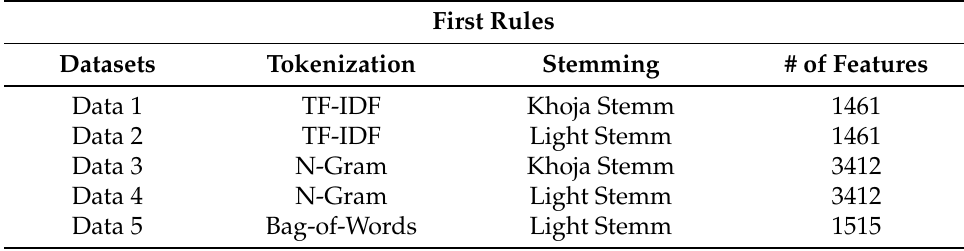
Table 1. The description of the first rules datasets.